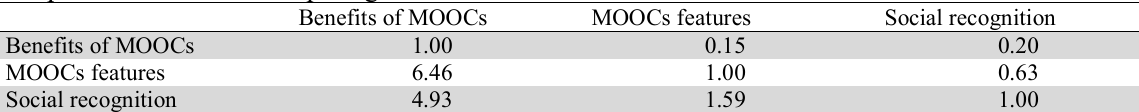
Comparison matrix for comparing the main factors Benefits of MOOCs MOOCs features Benefits of MOOCs